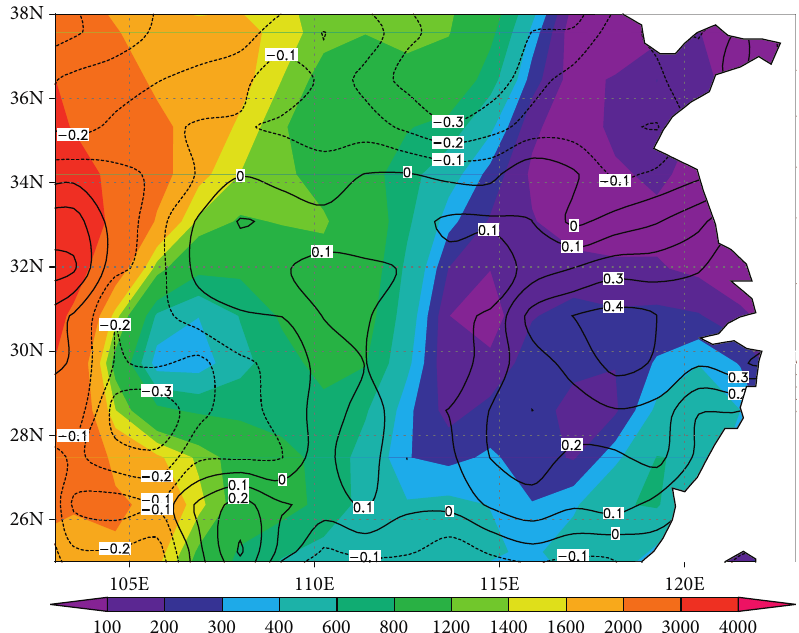
Figure 8: Distribution of correlation coefficients between the predicted summer precipitation by SINTEX-F and prewinter Niño3 SSTindex from 1982 to 2018. The contour lines denote the correlation coefficients. The shaded area denotes the model topography altitude (units: m). The black dots denote the stations in the western mountainous regions with the correlation coefficients between the JJA precipitation and the prewinter Niño3 SST above 95% confidence